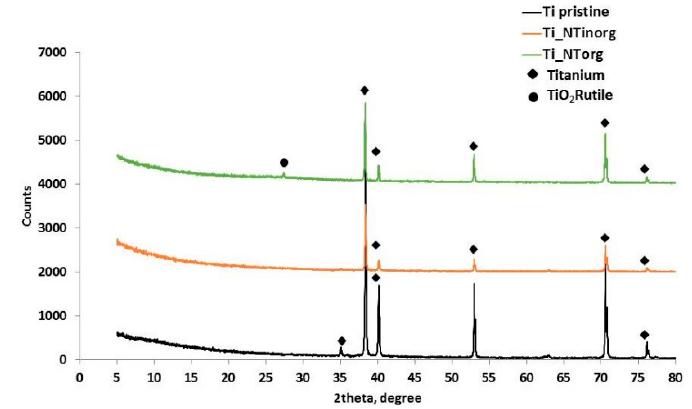
Figure 3. Comparison of X-ray diffraction pattern of Ti pristine sample (curve black), Ti_NT inorg sample (curve orange), and Ti_NT org (curve green).